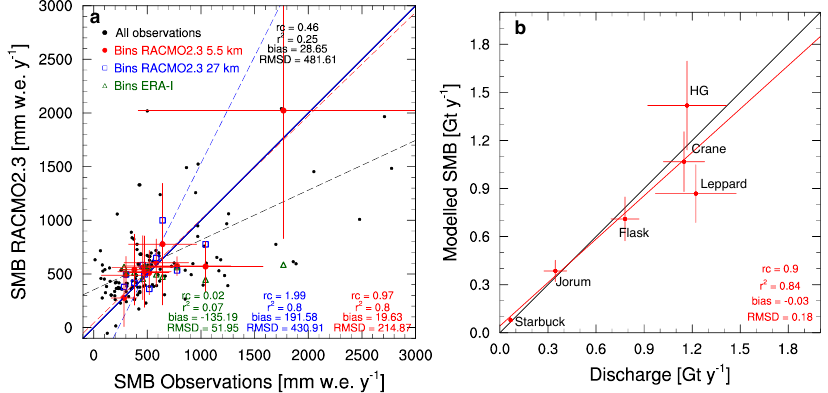
Figure 3. (a) Modelled RACMO2.3 SMB at 5.5km as a function of in situ SMB observations (black dots), and the height bins as defined in Fig. 2 for RAMCO2.3 5.5km (red dots), RACMO2.3 27km (blue squares) and ERA-Interim (green triangles) in mmweyr − 1 . Error bars represent 1 standard deviation within the height bins (for clarity error bars for RACMO2.3 27 km and ERA-Interim are not plotted). Dashed lines represent the linear regressions lines. Two locations with either observed or modelled SMB values > 3000mmweyr − 1 , as well as one binned 27km location, are off the chart and are not shown for clarity. (b) Modelled RACMO2.3 SMB at 5.5km (with 1 standard deviation) as a function of drainage basins discharge estimates (with uncertainty) (Wuite et al., 2015) in Gtyr − 1 . The red line represents the regression line of modelled SMB with discharge estimates. Basin locations are shown in Fig.